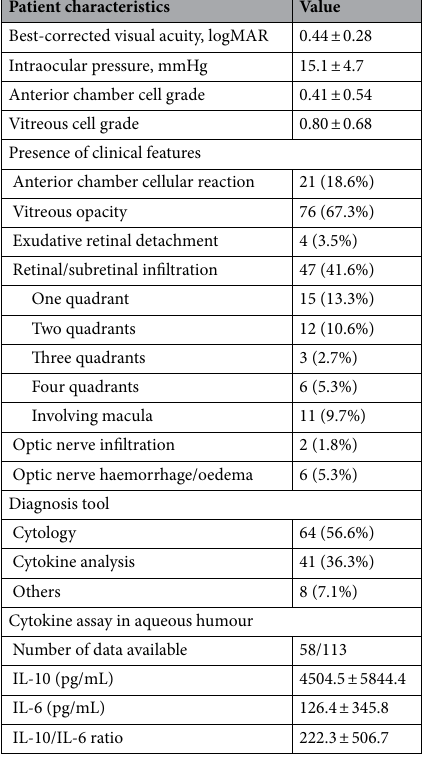
Table 2. Baseline ocular findings of patients with vitreoretinal lymphoma. Data are expressed as mean ± standard deviation (95% confidence interval).